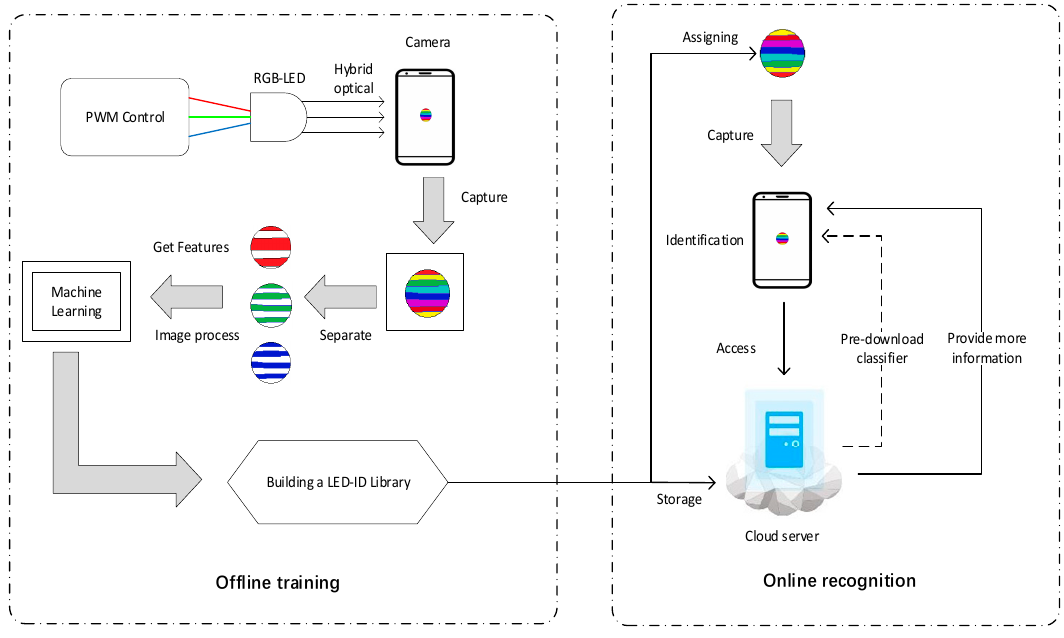
Figure 3. System overview.